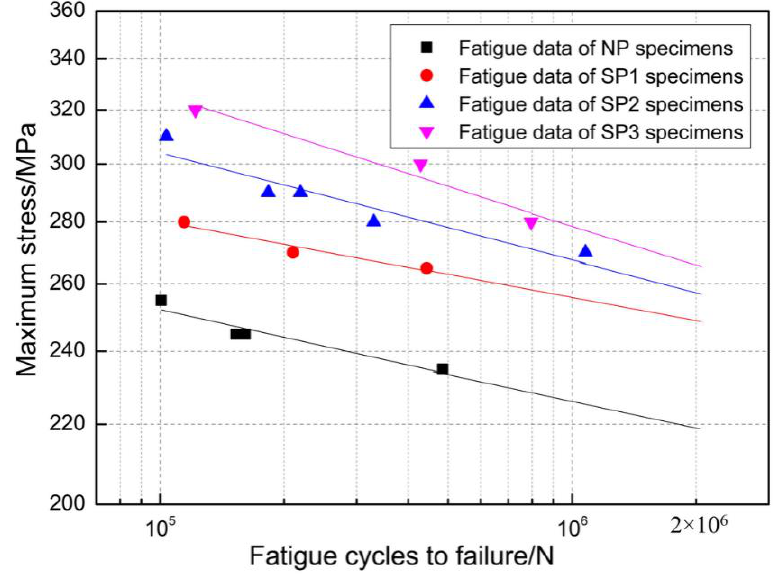
Figure 7. Fatigue data and S-N curves of NP, SP1, SP2 and SP3 specimens.